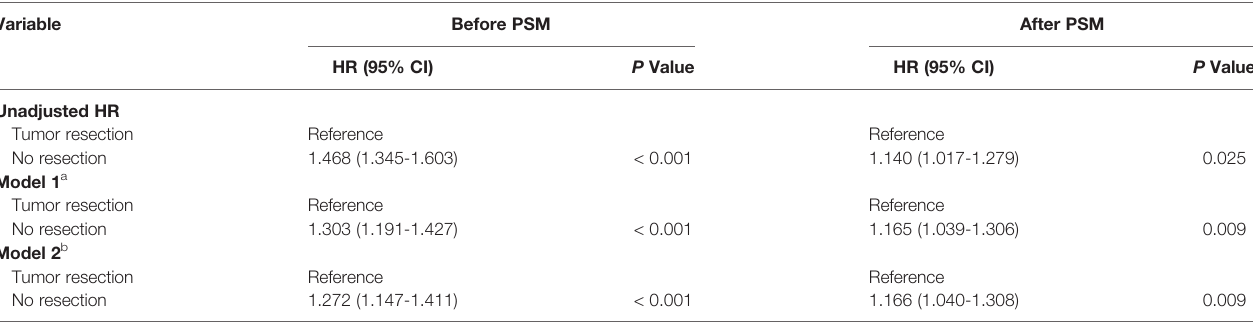
TABLE 3 | Multivariate competing-risks regression analysis of cardiovascular